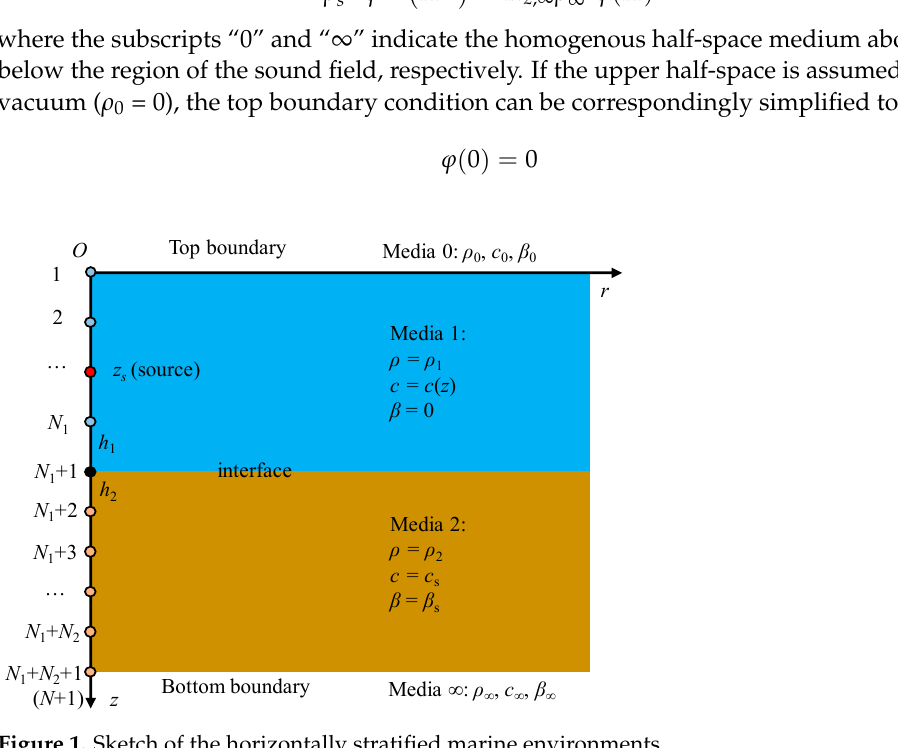
Figure 1. Sketch of the horizontally stratified marine environments.